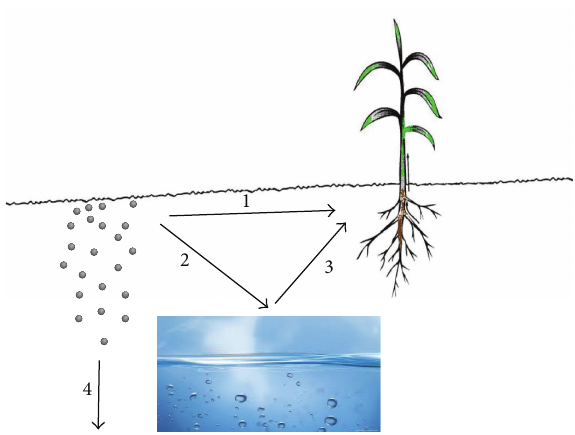
Figure 4: Interaction of engineered nanomaterials in the envi- ronment. (1) Engineered nanomaterials absorbed directly to plant root. (2) Engineered nanomaterials mixed with water medium. (3) Engineered nanomaterials mixed with water and transferred to plant. (4) Engineered nanomaterials stayed in the